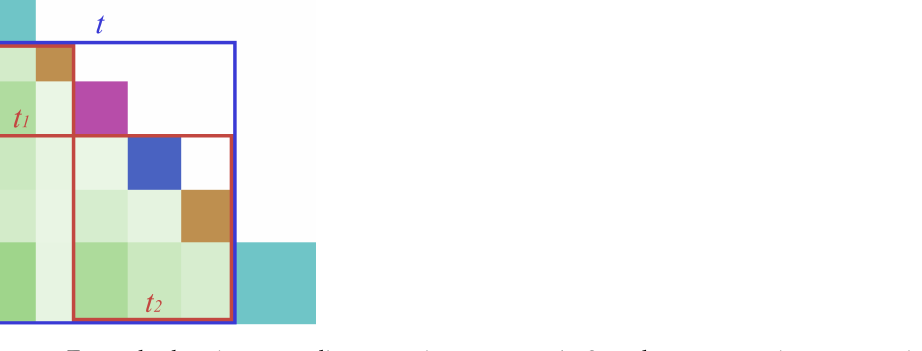
Figure 15. Example showing two adjacent topic segments t 1, t 2, and a parent topic segment t in a small set of topic segments.